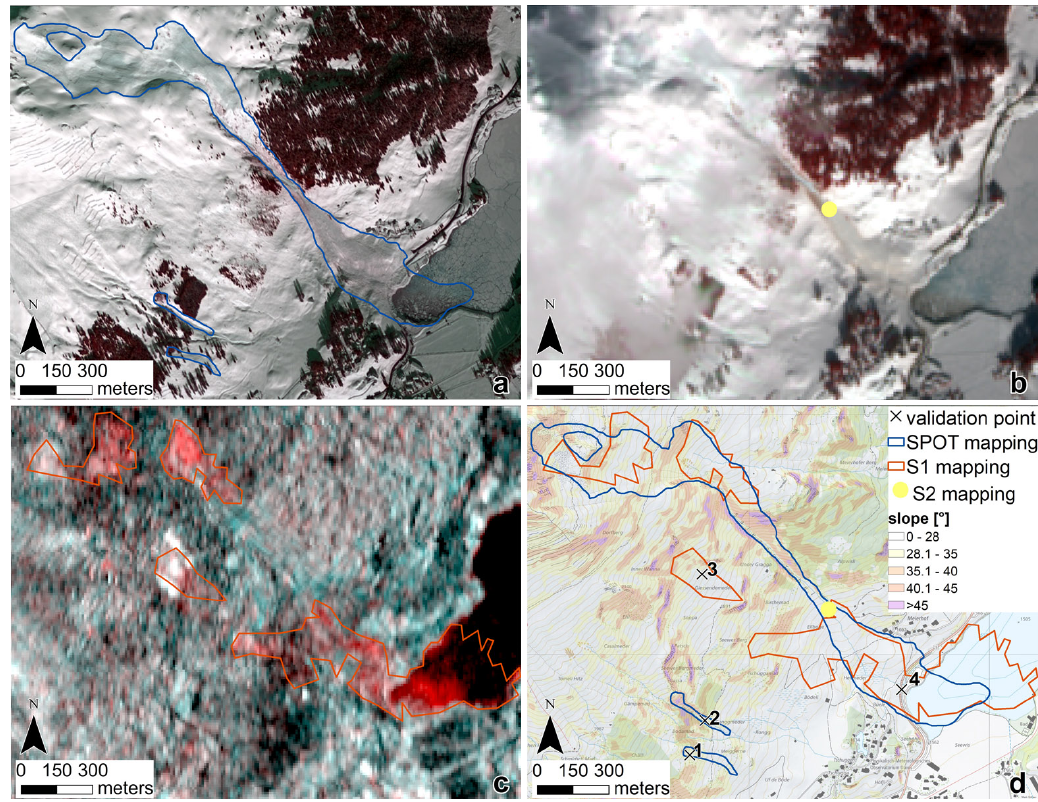
Figure 4. Example of the mapping in 2019 and the base data used by the different methods for visual interpretation. (a) SPOT mapping (image: 16 January 2019, SPOT 6 © Airbus DS2019), (b) S2 mapping (image: 17 January 2019), (c) S1 mapping. The image shows an RGB composite of the pre- and post-avalanche event LRW images: red represents the post-event image, green-blue the pre-event image (pre-event image: 12 and 13 January 2019, post-event image: 18 and 19 January 2019, Sentinel-1 and Sentinel-2 © Copernicus data, 2019). (d) Overlay of the three mapping results on the Swiss Map Raster 25 with slope and the location of four validation points. At the validation points 1, 2 and 4 avalanches were confirmed by ground truth, whereas at validation point 3 no avalanche exists in the ground truth (S1 false positive). For validation points 1–3, each mapped avalanche corresponds to a single validation point (one-to-one join), whereas for the validation point 4, multiple S1 polygons correspond to a single validation point (one-to-many join) generated from ground truth (map source: Federal Office of